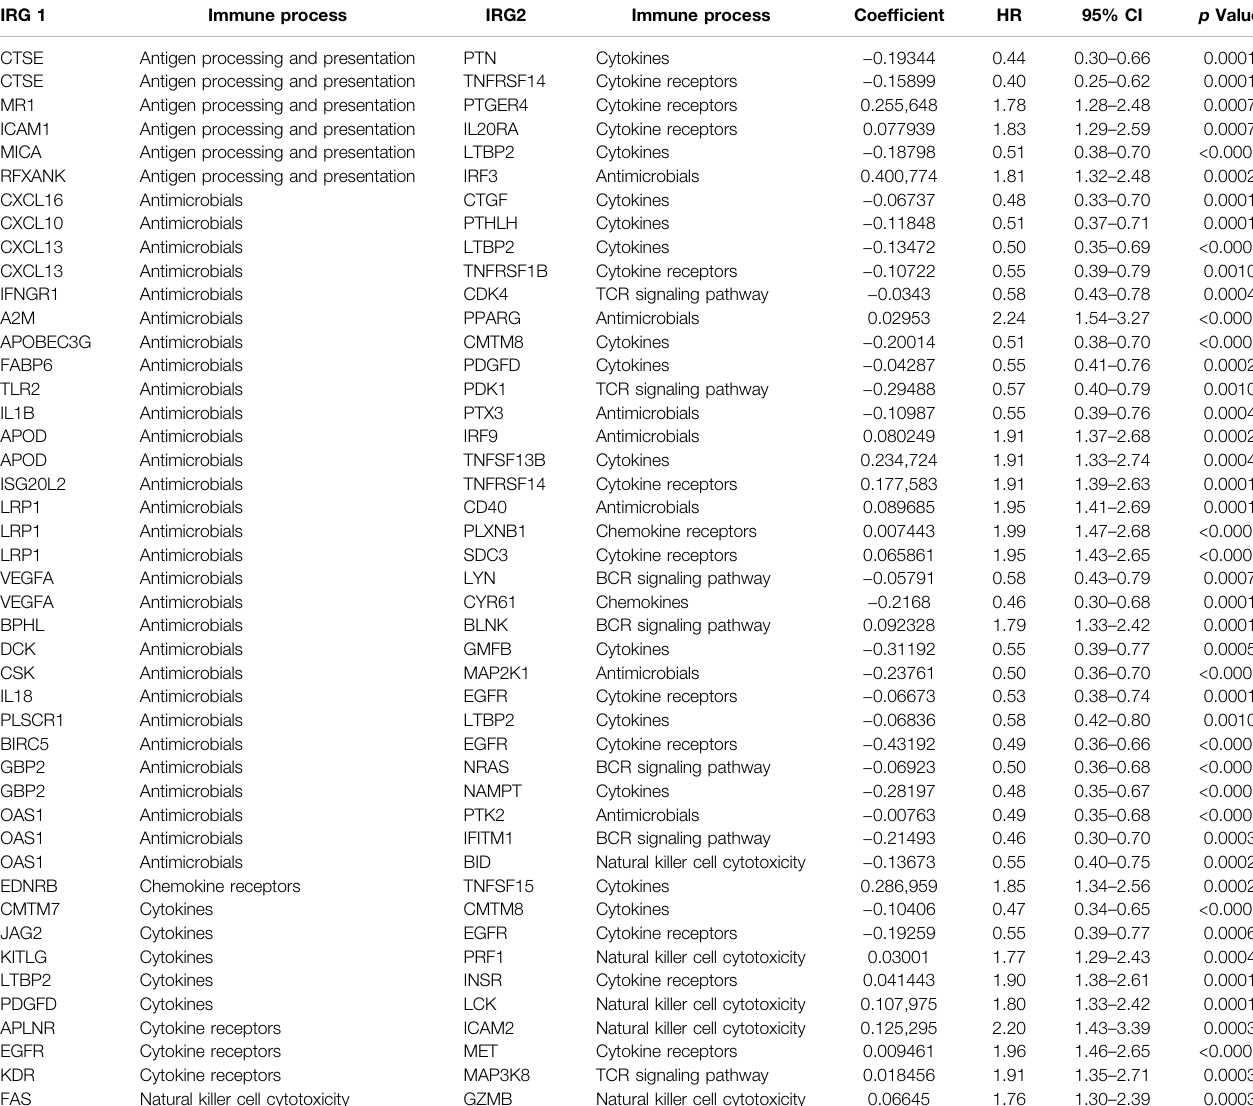
TABLE 1 | Immune-related gene pairs in signature